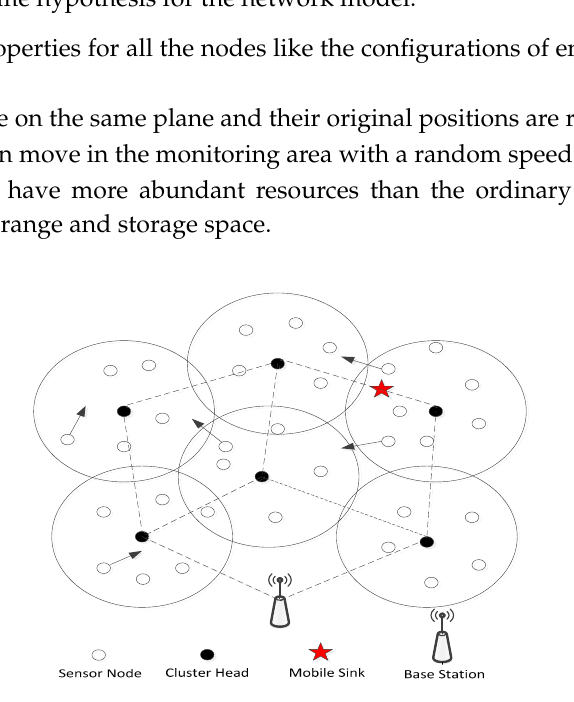
Figure 1. The schematic model of the network.